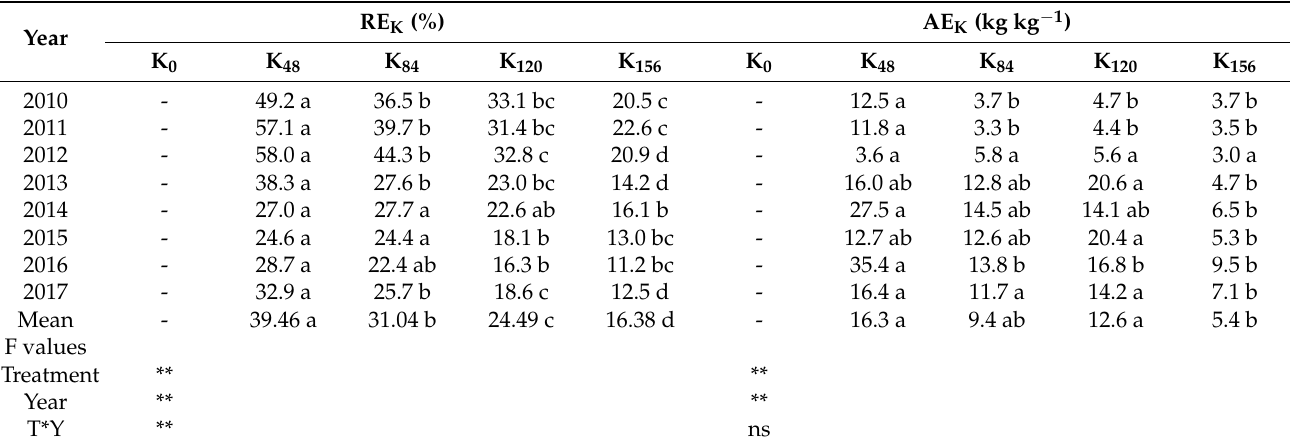
Table 1. Effects of different K fertilization rates on K recovery efficiency (RE K ) and K agronomic efficiency (AE K ) in maize season between 2010 and 2017.